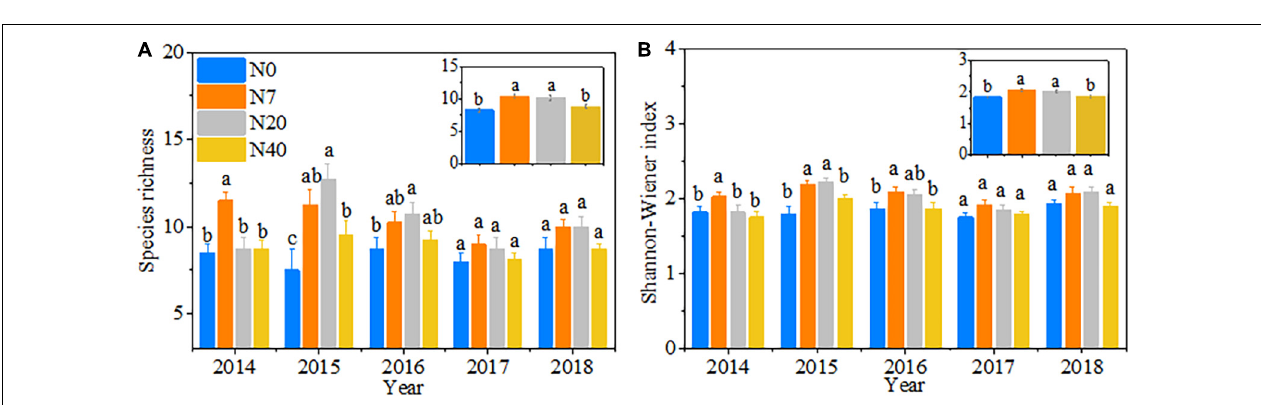
FIGURE 3 | Response ratio of (A) aboveground biomass (AGB), (B) forage grass biomass (GB) and (C) forb biomass (FB) and changes in (D) net ecosystem CO 2 exchange (NEE), (E) ecosystem respiration (ER), and (F) gross ecosystem productivity (GEP) from 2014 to 2018.